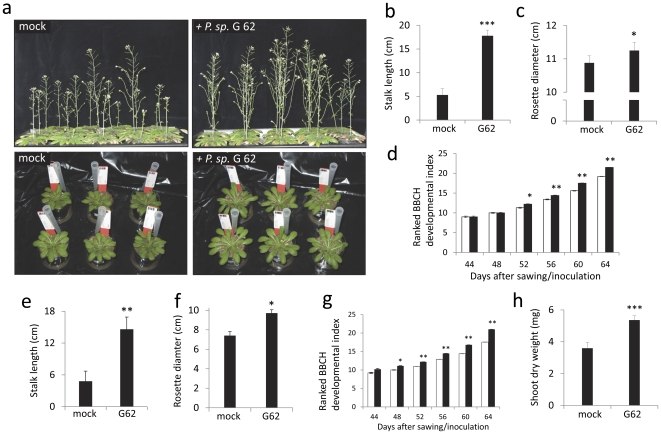
Growth effects of P. sp. G62 on Arabidopsis ecotype Col-0 on different substrates.a: top panels: Col-0 with and without bacteria (mock) after a 68-day growth period (peat substrate), bottom panels: Col-0 at rosette stage with and without bacteria (mock) grown in sandy soil. b: stalk length. c: rosette diameter. d: developmental index (b–d: grown on peat substrate). e: stalk length. f: rosette diameter. g: developmental index (e–g: grown on sandy soil). h: shoot dry weight (grown in agar medium). Mean values ± SE, asterisks indicate p-values (*: p<0.05; **: p<0.01; ***: p<0.001).